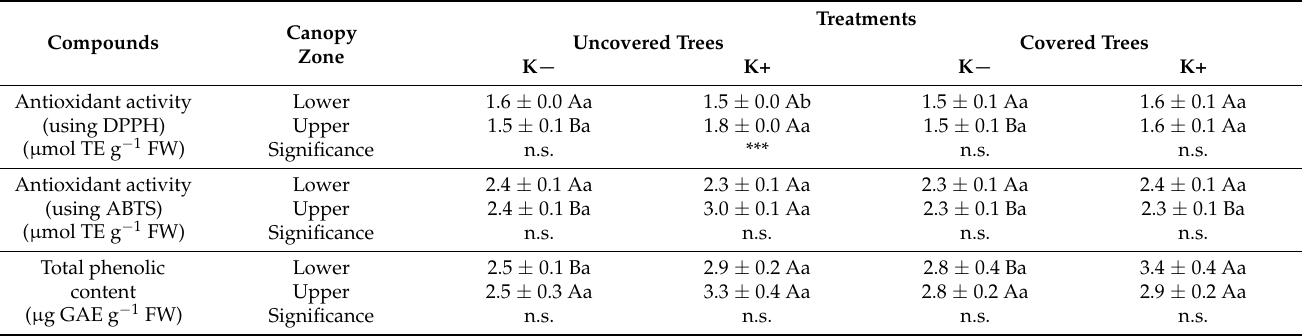
Table 3. Effects of two potassium spray treatments, conventional K regime (4 sprays during the season: K − treatment) or intensive K regime (7 sprays during the season: K+ treatment), on antioxidant activity and total phenolic content in whole fruits of sweet cherry (cv. Regina) produced in covered and uncovered trees. Fruits from the upper and lower zone of the canopy were separately analyzed. The statistical significance between canopy zones for each treatment is also shown. Abbreviations: TE (Trolox equivalents); GAE (gallic acid equivalents); ABTS (2,2- Azino bis (3- ethylbenzothiazolin-6-